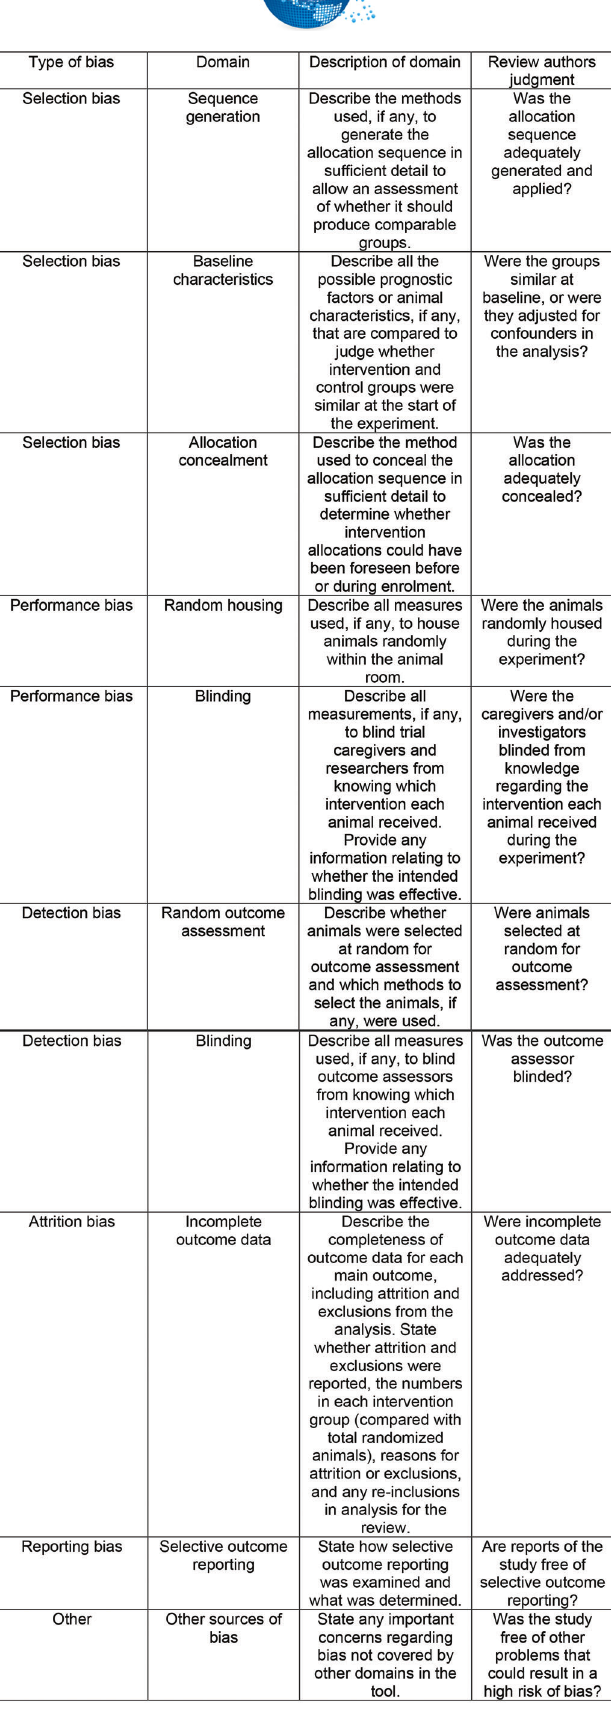
Figure 2 - Representation of the SYRCLE ’ s risk of bias tool for animal studies. Hooijmans et al. (43).